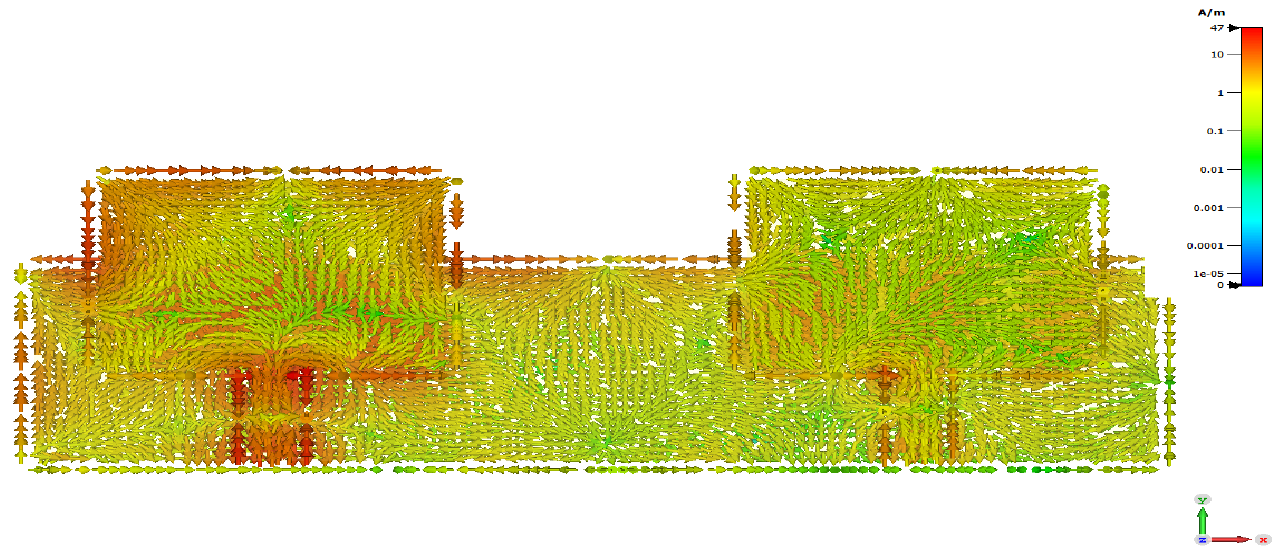
Figure 2. Surface current density of 2 × 1 microstrip patch antenna array without decoupling slab.